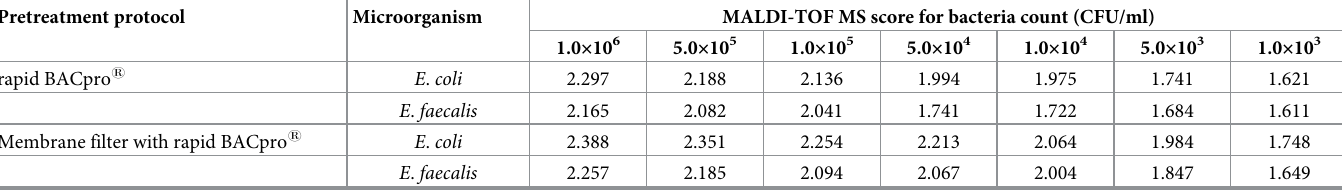
Table 2. MALDI-TOF MS scores for bacteria count of Escherichia coli and Enterococcus faecalis. Pretreatment protocol